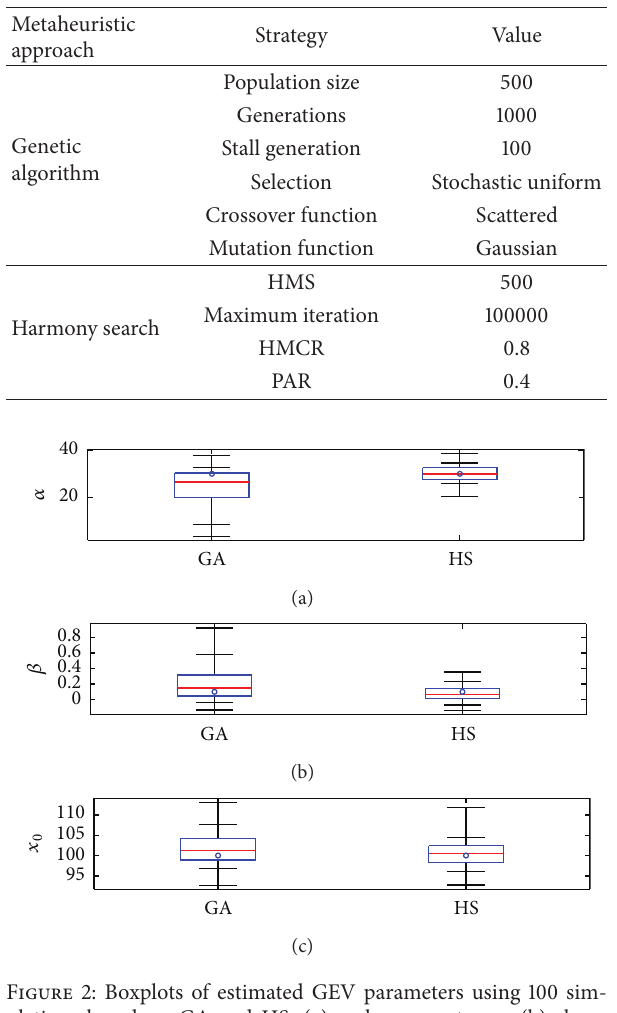
Note that higher CC and CE values and lower RMSE values represent better performance. Estimated statistics are described with boxplots. Boxes indicate the interquartile range (IQR), and whiskers extend to 1.5 IQR. The horizontal lines inside the boxes depict the median of the data.